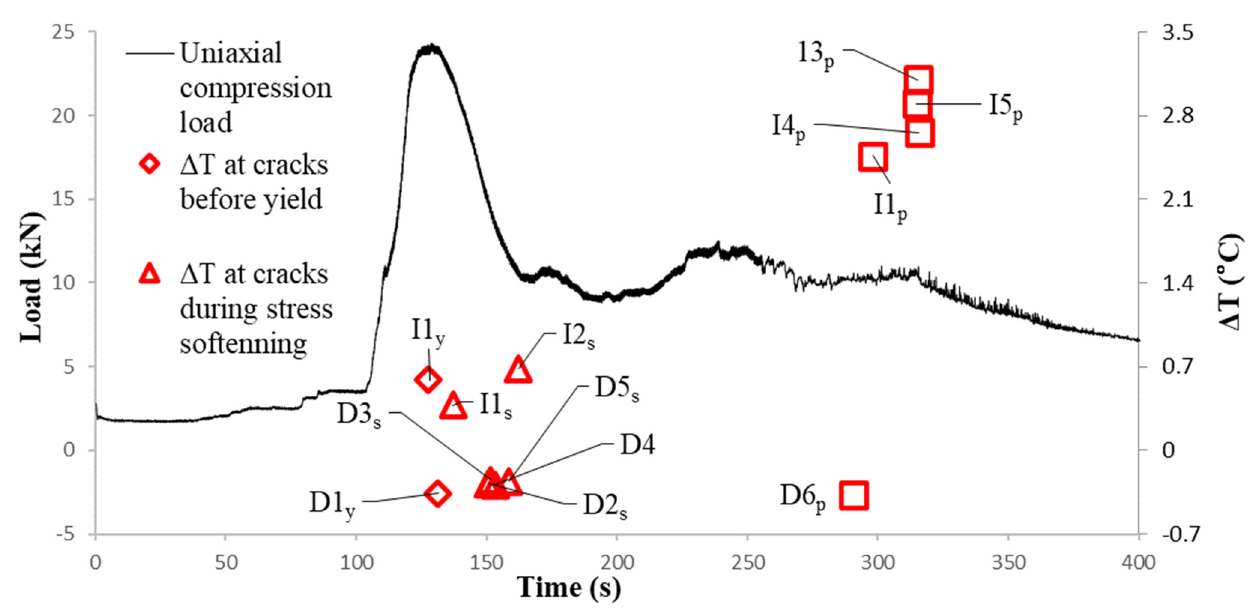
Figure 16. Load–time curve with magnitudes of temperature change at cracks.